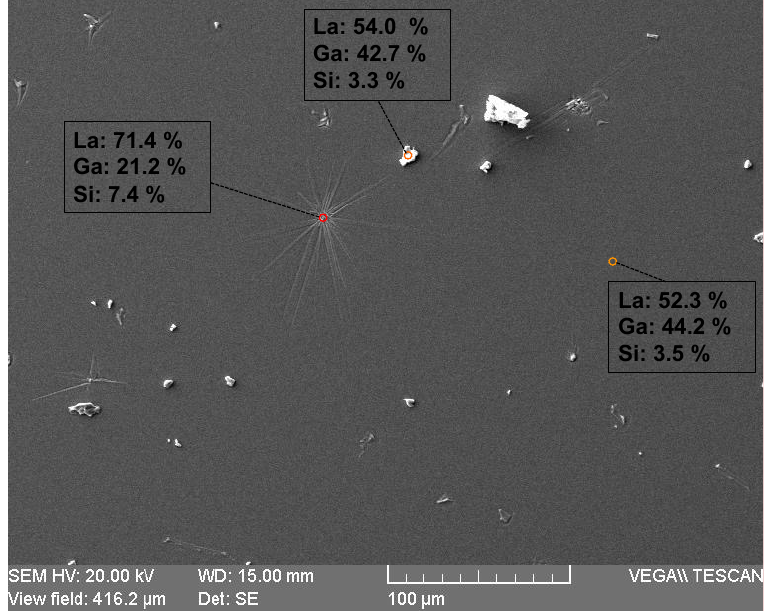
Figure 8. SEM image of LGS surface after a one-month annealing period at 1000 °C in an air atmosphere. Colored spots indicate the locations of EDXS measurements.